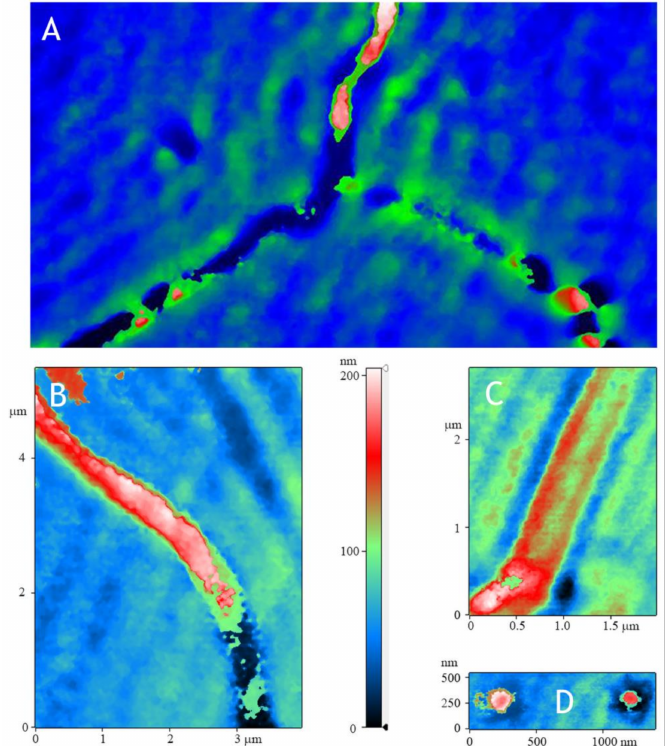
Figure 7. Reconstruction of the surface of the AP-ZnO material using modulation interference microscopy. ( A ) General view. ( B , C ) Maps with characteristic zinc oxide fusions. ( D ) Map with a single point of growth of zinc oxide.